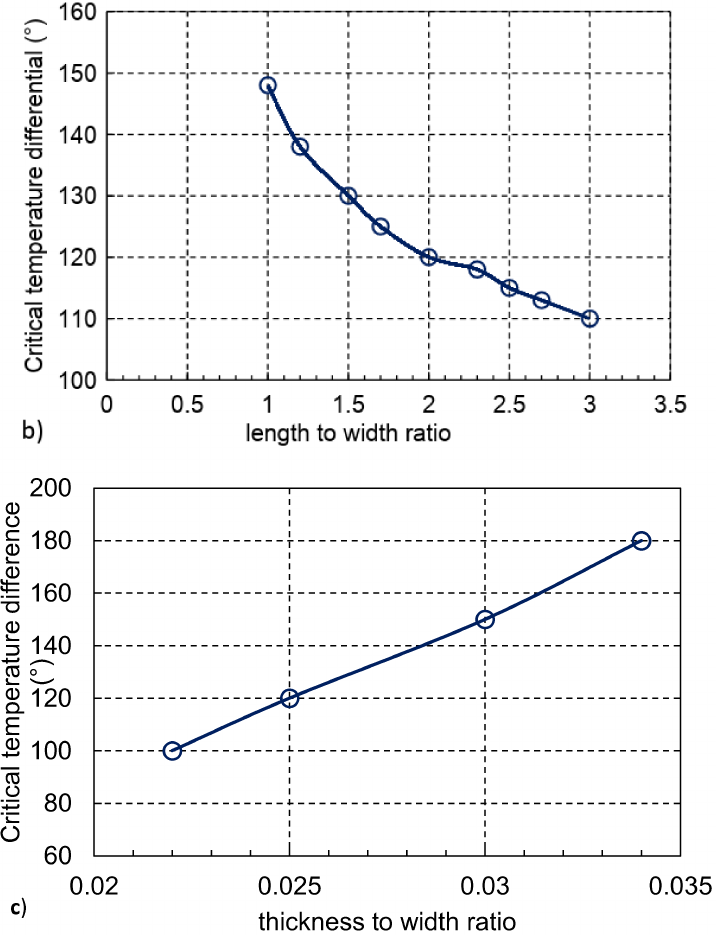
Figure 6. The effect on the critical temperature differential: ( a ) resilient modulus of subgrade; ( b ) length to width ratio; and ( c ) thickness to width